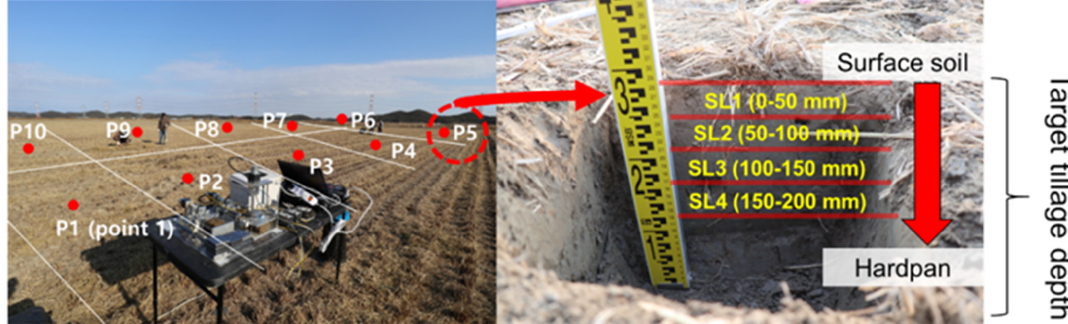
Figure 3. Soil environment analysis procedure considering depth distribution: Soil sampling using uniformed grid sampling method.